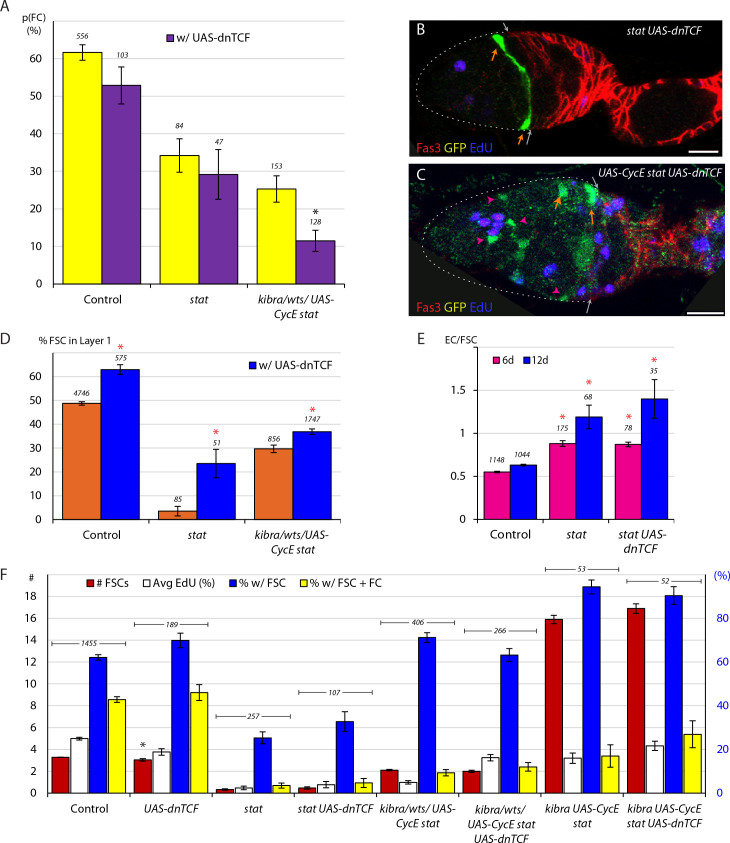
Decreasing Wnt signaling increases FSC division and posterior location but does not strongly alter loss of FC production or increased FC production in the absence of JAK-STAT signaling.(A) Average probability of a layer 1 FSC becoming an FC during a single budding cycle for the indicated MARCM lineage genotypes with the number of informative germaria scored and significant differences resulting from the presence (purple) of UAS-dnTCF (black asterisks, p<0.05). (B, C) Reduction of Wnt signaling with UAS-dnTCF increased the very low incorporation of EdU (blue) into (B) stat and (C) UAS-CycE stat mutant FSC lineages (green). GFP-positive cells with EdU (orange arrows) and without EdU (blue arrow) are indicated together with the Fas3 (red) anterior border (gray arrows). (D) Proportion of FSCs in layer one for the indicated MARCM lineage genotypes, with the number of FSCs scored and significant differences resulting from the presence (blue) of UAS-dnTCF (red asterisks, p<0.001). (E) ECs produced per anterior FSC from 0-6d (magenta) and 0-12d (blue) for the indicated MARCM lineage genotypes with the total number of informative germaria scored and significant differences from control values indicated (red asterisks, p<0.001). (F) Number of FSCs per germarium (red) using y-axis scale on the left, percentage of FSCs incorporating EdU (aggregating all layers, white), percentage of ovarioles with a marked FSC (blue) and percentage of ovarioles with a marked FSC and marked FCs (yellow) (percentage y-axis scale in blue on the right) for the indicated genotypes, with the number of germaria scored at 12d (EdU was scored at 6d) and significant differences for the number of FSCs (black asterisks, p<0.05) compared between genotypes with and without UAS-dnTCF. All scale bars are 10 μm.Figure 6—figure supplement 1—source data 1.Numerical data for graphs in Figure 6—figure supplement 1.